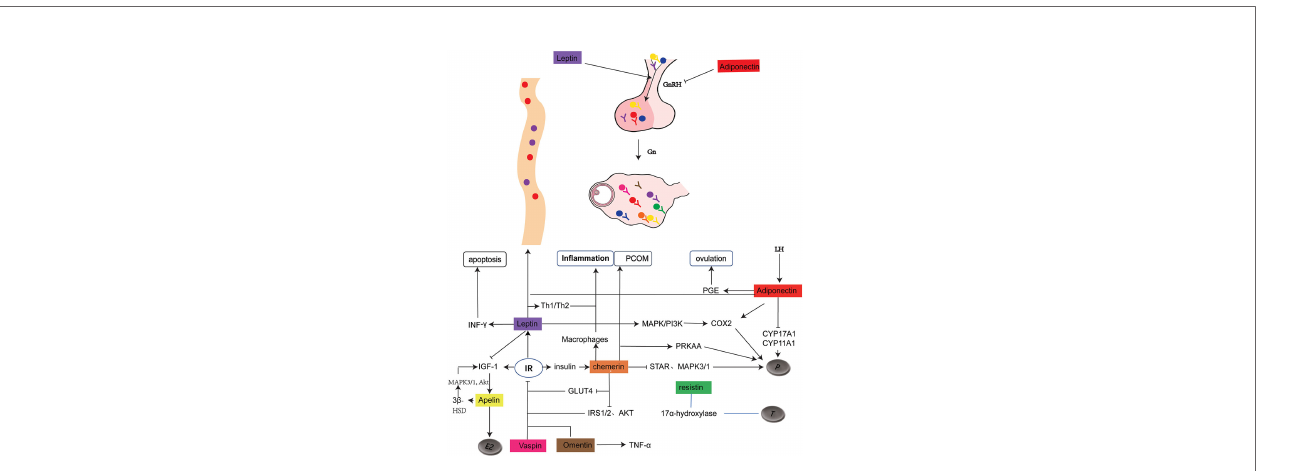
FIGURE 1 | Schematic representation of adipokine expression and its role in PCOS. The solid dots of different colors represents the distribution of adipokines, with the corresponding Y as their receptors . represents for promotion and inhibition respectively. As shown in the fi gure, leptin and adiponectin regulates hypothalamic secretion of GnRH. Leptin, together with Adiponectin and Chemerin regulates progesterone production. Resistin is related to testosterone production without clear mechanism. Chemerin and Omentin are associated with in fl ammation. Chemerin, Apelin, Leptin, Vaspin, Omentin play a role in regulating IR. In addition, Adiponectin is closely related to ovulation and Chemerin is involved in the formation of PCOM.GnRH, gonadotropin-releasing hormone; Gn, gonadotropin; LH, luteinizing hormone; P, proges-terone; T, testosterone; E2, Estrodiol; PCOM, polycystic ovary morphology; PGE, prostaglandin E; MAPK, mitogen-activated protein kinase; COX2, cyclooxygenase-2; CYP17A1, cytochrome P45017A1; CYPI1A1, cytochrome P45011A1; IGF-1, insulin-like growth factor 1; IR, insulin resistance; IRS, Insulin receptor substrate; AKT, protein kinase B; INF- y , Interferon- y ; 3 8 -HSD, 3 6 -hydroxysteroid dehydrogenase; GLUT4, glucose transporter4.